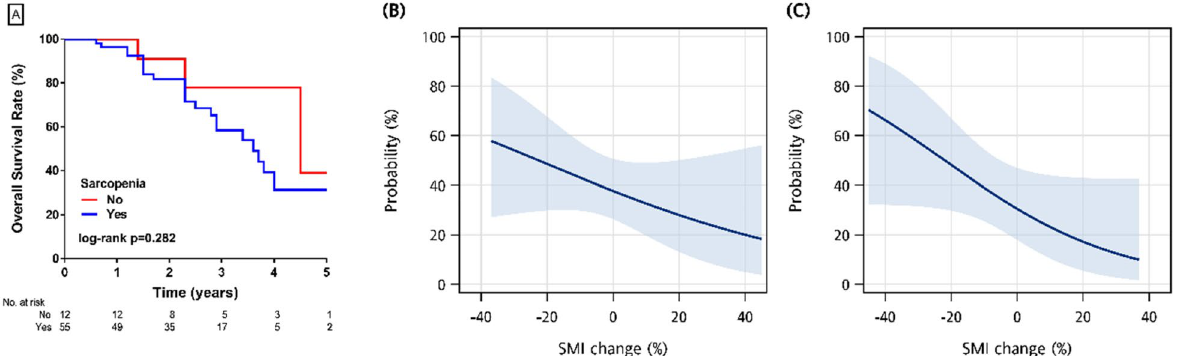
Figure 3. ( A ) Median survival time of the patients with sarcopenia: 3.6 years: without sarcopenia: 4.5 years; ( B ) probability of death by percentage change in SMI after chemotherapy; ( C ) probability of death by percentage change in SMI after